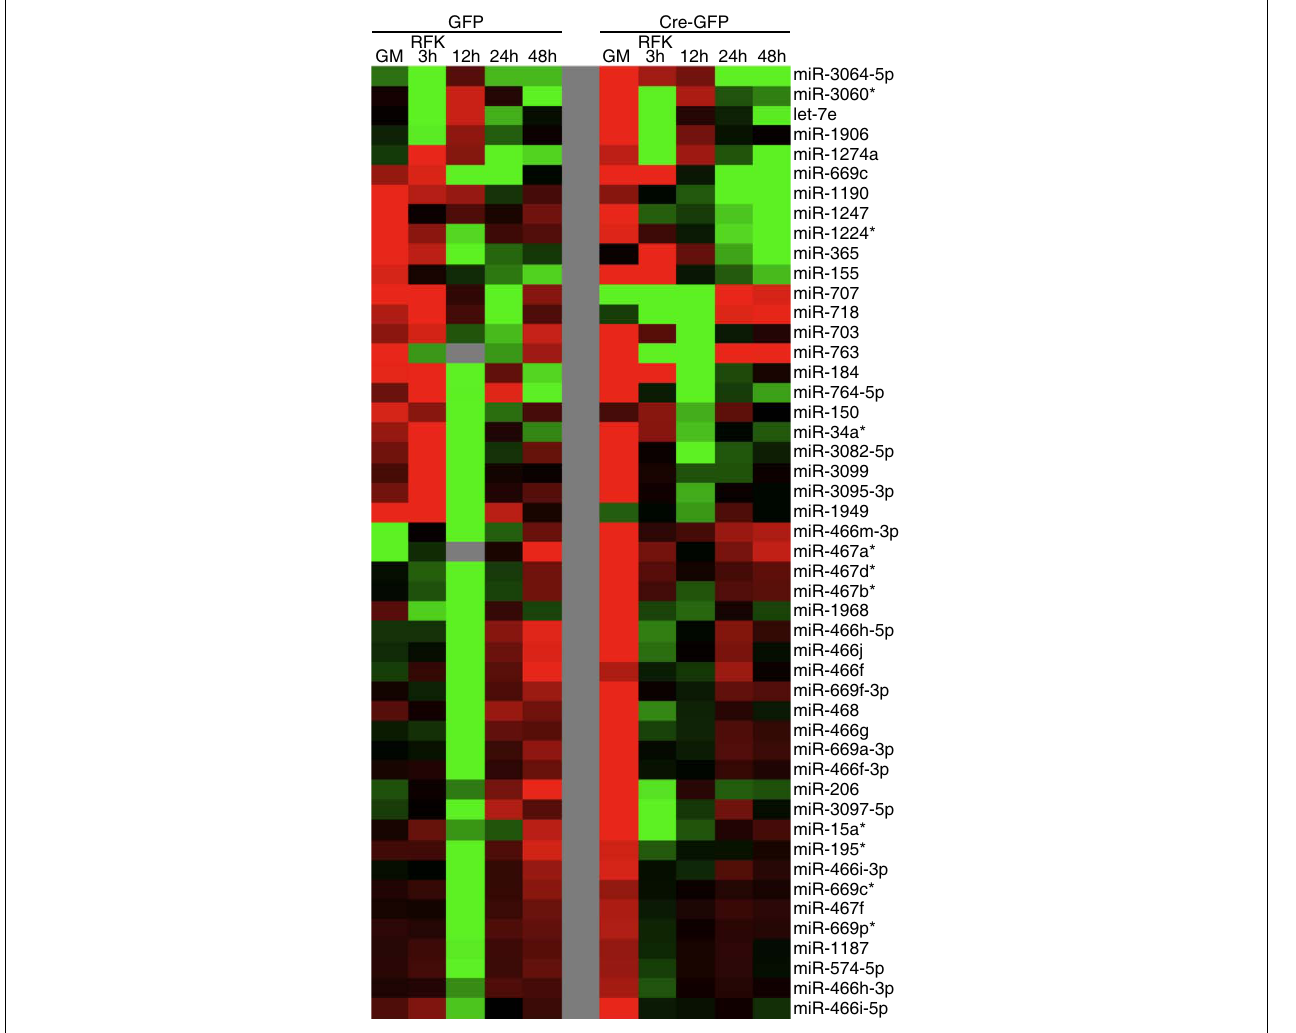
FIGUREA5 |Validation of the clustering approach to identify potential novel REST miRNA targets. Regardless of the clustering algorithm, miRNAs from miR-297-669 locus readily form clusters, confirming the validity of our clustering approaches.